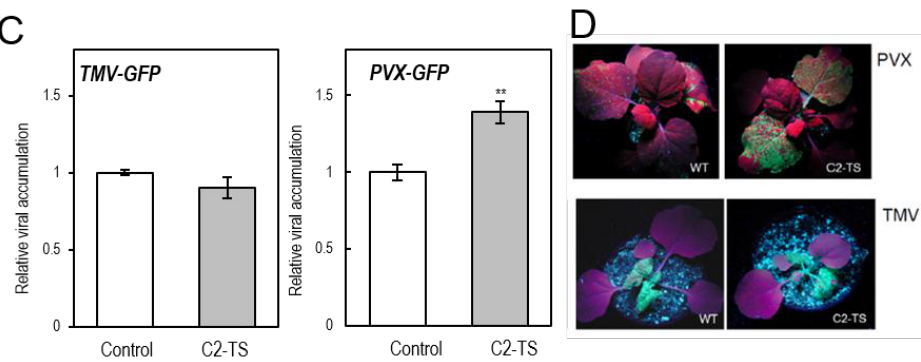
Figure 4. Transgenic C2-TS plants are more susceptible to Pseudomonas syringae pv. tomato DC3000 and Potato virus X . ( A ) Bacterial growth of Pto DC3000 in wild-type or C2-expressing Arabidopsis plants upon inoculation by infiltration. Samples were taken at 4 dpi. Values are the mean of five plants. Bars represent standard error. The asterisk indicates a statistically significant difference from the control sample (* p -value < 0.05) according to a Student’s t -test. Three independent experiments were performed with similar results; results from one representative experiments are shown; ( B ) Bacterial growth of wild-type Pto DC3000, a ∆ hrcC mutant, or a wild-type strain expressing the heterologous effector AvrRpt2 on wild-type or C2-TS-expressing Arabidopsis plants. Values represent the average of five plants. Bars represent standard error. The asterisk indicates a statistically significant difference from the control sample (* p -value < 0.05) according to a Student’s t -test. Three independent experiments were performed with similar results; results from one representative experiments are shown; ( C ) Infection of wild-type (WT) or C2-TS-expressing N. benthamiana plants with PVX-GFP or TMV-GFP at 10 dpi. Values represent relative expression of viral RNA estimated by semi-quantitative RT-PCR, and are the average of ten infected plants. Bars represent standard error. Asterisks indicate a statistically significant difference from the control sample (** p -value < 0.01) according to a Student’s t -test. Two independent experiments were performed with similar results; results from one representative experiment are shown; ( D ) Pictures of representative TMV-GFP and PVX-GFP infected plants under UV light.